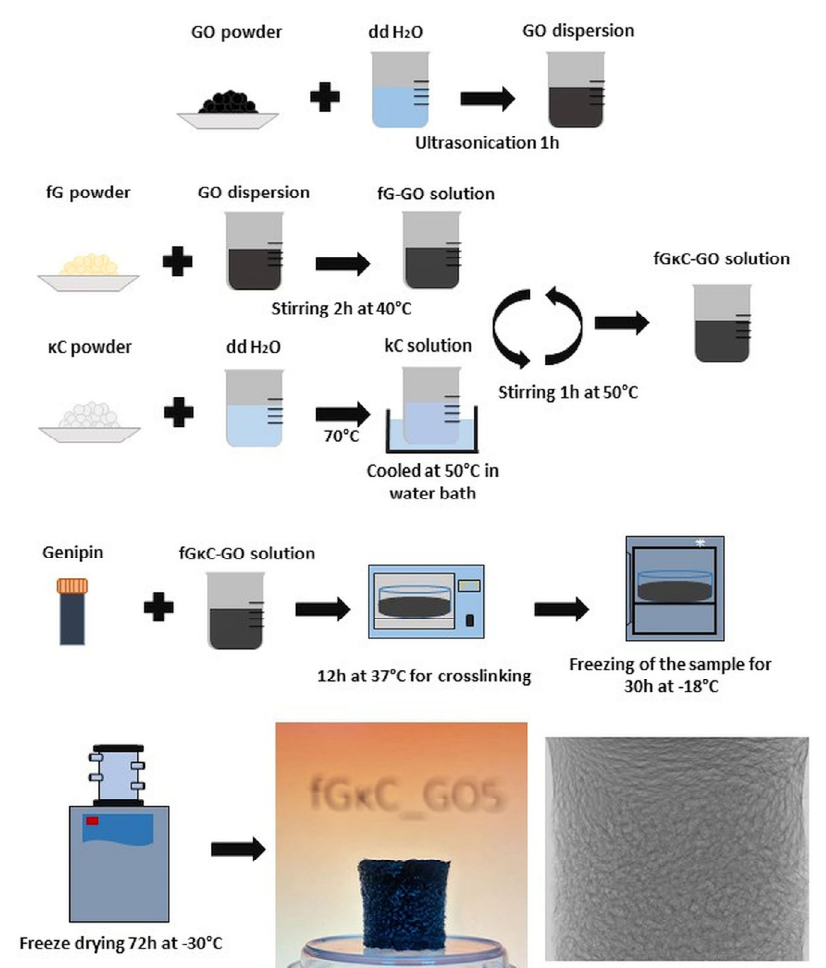
Figure 1. Schematic diagram of fG κ C and GO reinforced fG κ C formulations .